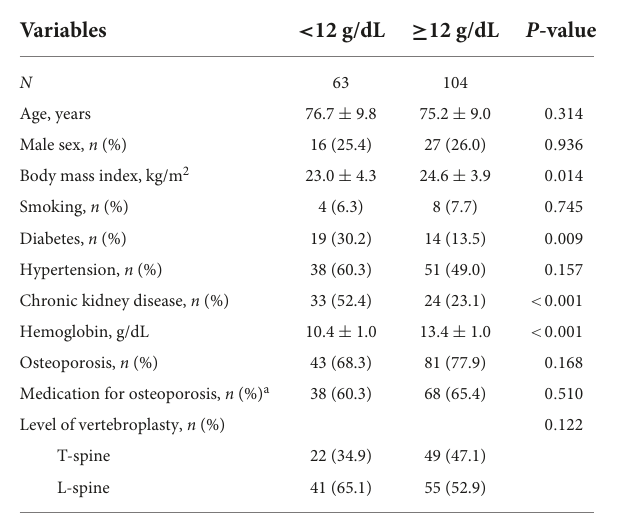
TABLE 1 Baseline characteristics of the study population according to pre-operative hemoglobin.